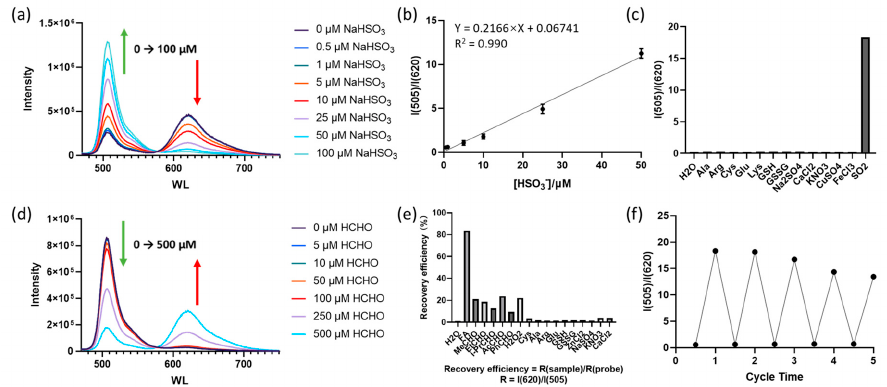
Figure 1. Necessary conditions for FRET to occur: The normalized fluorescence spectrum of the do- nor part (BODIPY, compound 3 , shown as the green curve) overlaps the normalized absorption spectrum of the acceptor part (benzopyrylium, compound 2 , shown as the red curve).